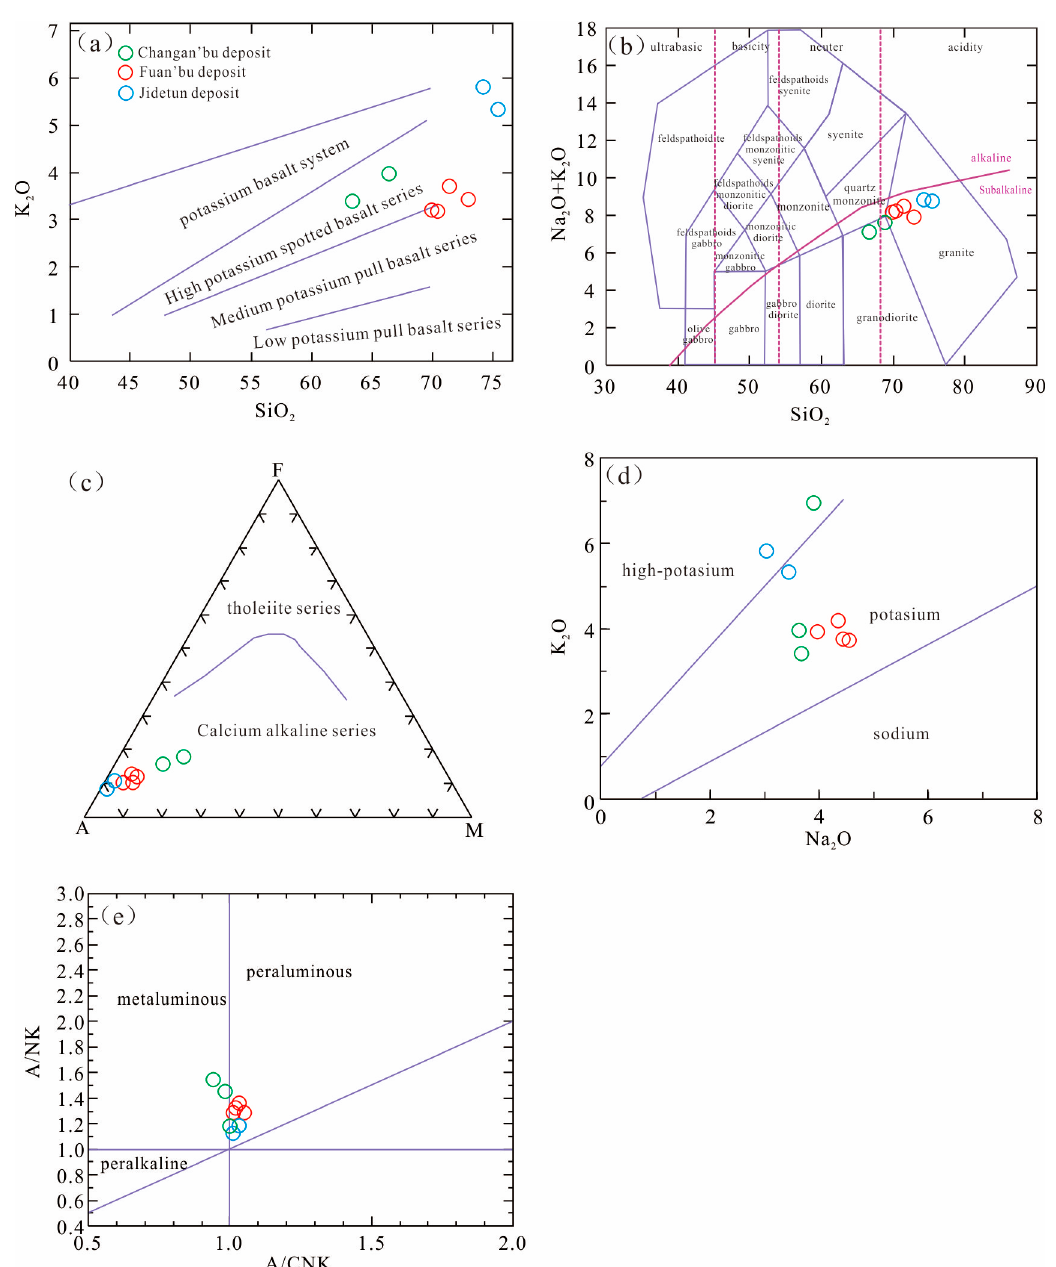
Figure 6. Major element diagrams for ore-hosting rocks from the Chang’anbu, Fu’anbu, and Jidetun deposits [13].( a ) SiO 2 − K 2 O; ( b ) SiO 2 − K 2 O + Na 2 O; ( c ) F–A–M; ( d ) Na 2 O − K 2 O; ( e )